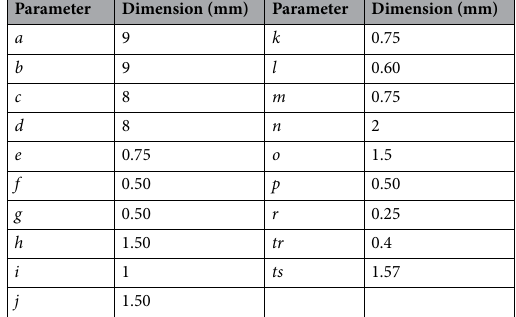
Parameter Dimension (mm)